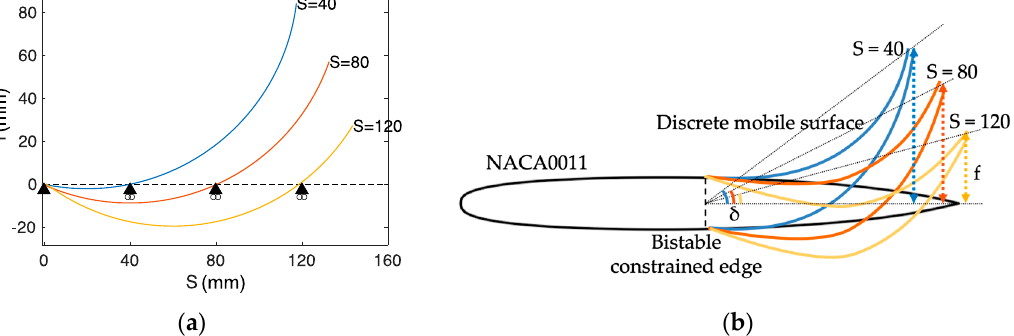
Figure 13. FE bistable model (two stable state shapes deformations): simulated and measured cambers.